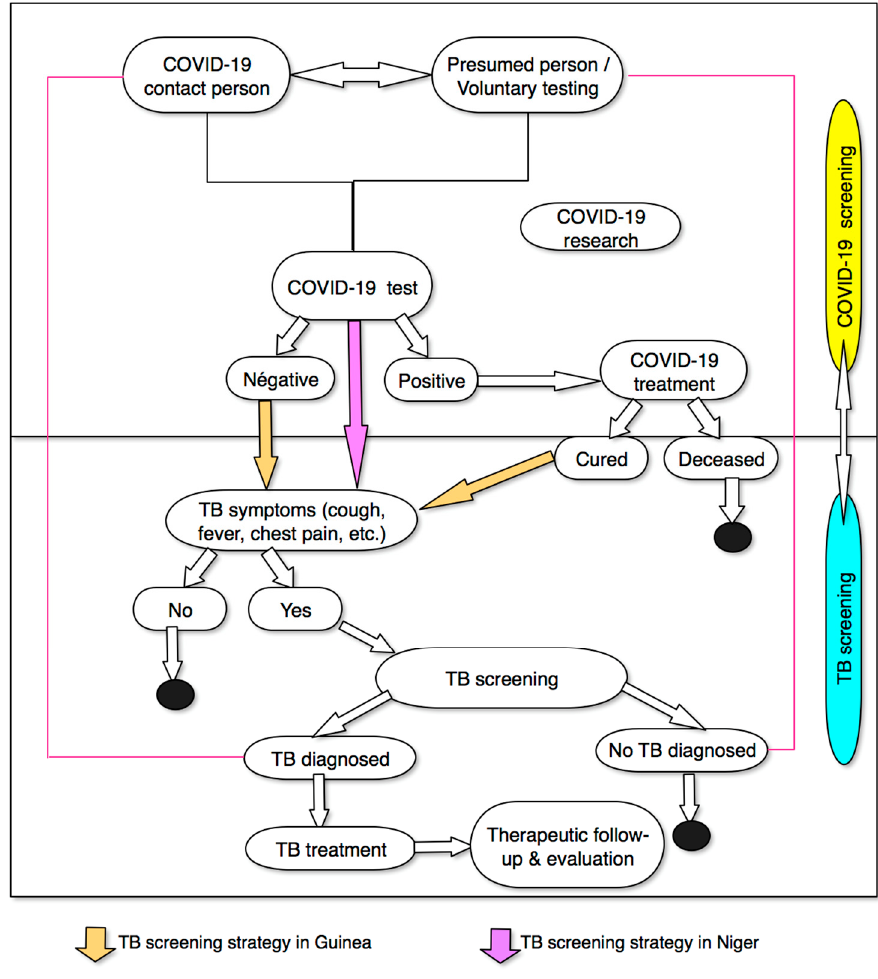
Figure 1. Integrated TB/COVID-19 screening algorithm used in the study.